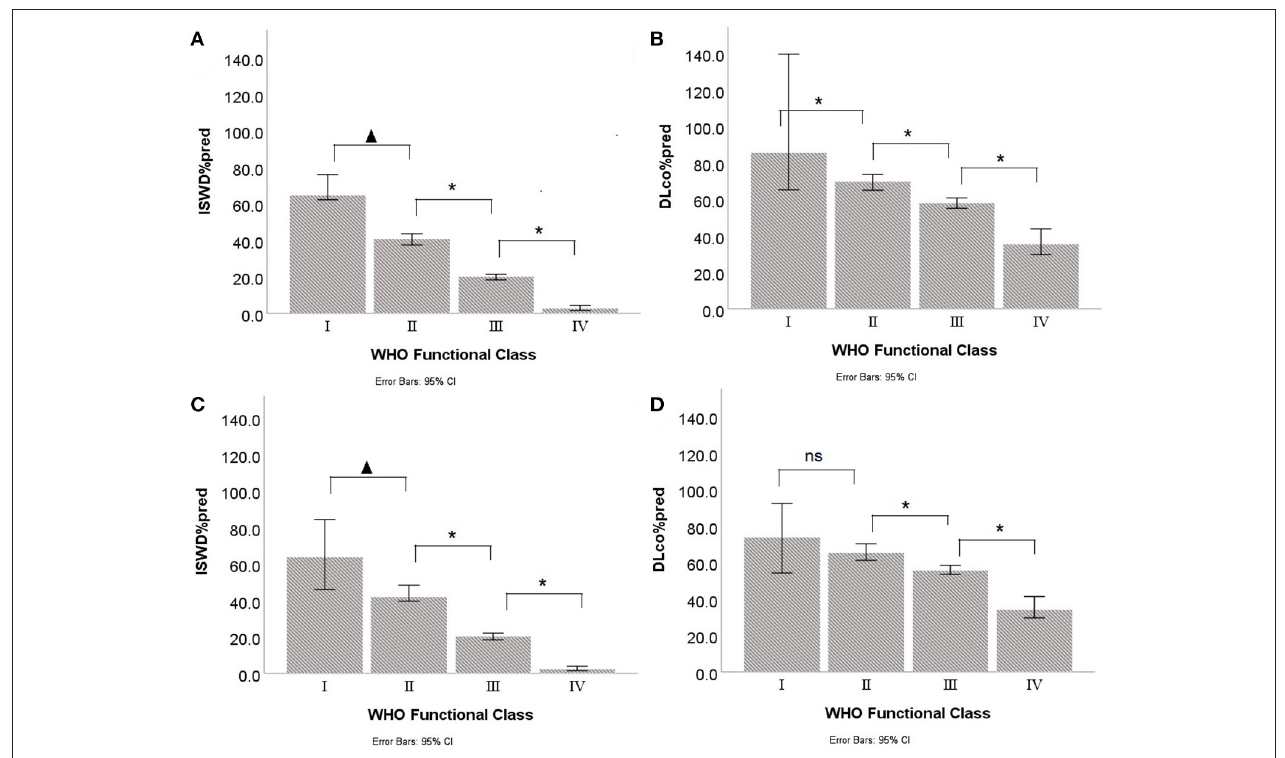
FIGURE 3 | Median and interquartile ranges for Incremental shuttle walk distance percent predicted (ISWD%pred) and Diffusing capacity across the lung for carbon monoxide percent predicted (DLco%pred) by World Health Organization Functional Class (WHO FC) in (A,B) all patients and (C,D) with congenital heart disease patients excluded. p < 0.05; * p < 0.005; ns, not